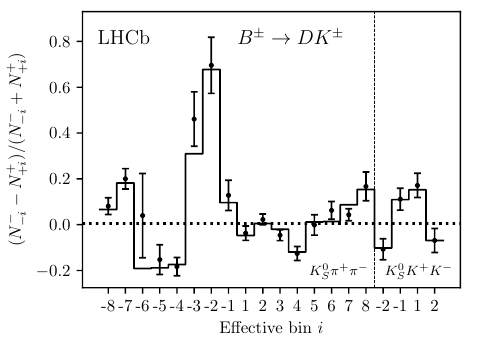
Figure 6 . The bin-by-bin asymmetries ( N − − N + ) / ( N − + N + ) for each Dalitz-plot bin number − i + i − i + i for (left) B ± → DK ± decays and (right) B ± → Dπ ± decays. The prediction from the central values of the CP -violation observables is shown with a solid line and the asymmetries obtained in fits with independent bin yields are shown with the error bars. The predicted asymmetries in a fit that does not allow for CP violation are shown with a dotted line. The vertical dashed line separates the K 0 π + π − and K 0 K + K − bins on the horizontal axis. S S